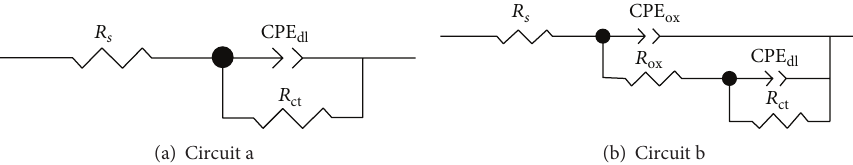
Figure 8: Electrical circuits used to simulate the EIS data for AISI-309 in molten salts 50 mol% V 2 O 5 -50mol% Na 2 SO 4 at 700 ∘ C.